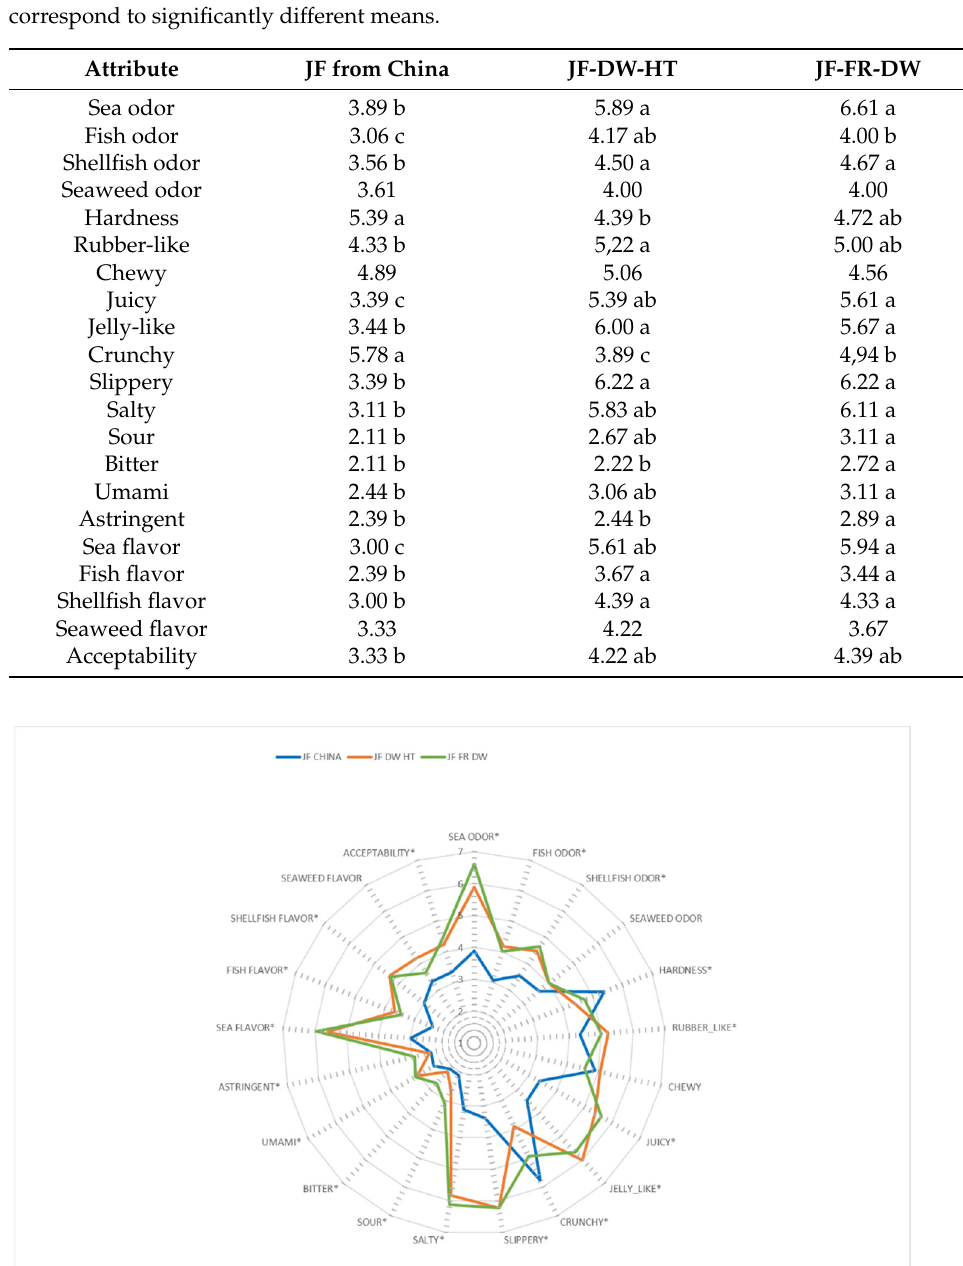
Figure 8. Spider plot of DA intensity scores by sample on a 9-point scale. Significant differences ( p < 0.005) are marked by *.